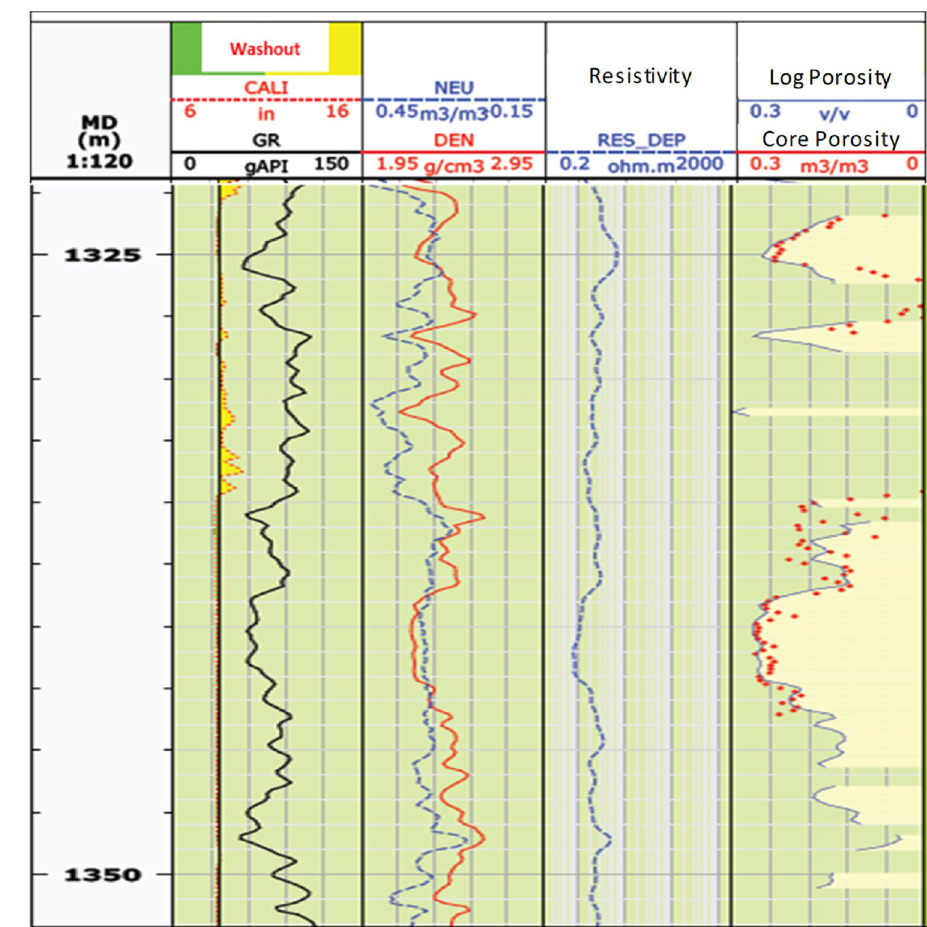
Fig. 7 Log plot of porosity versus core porosity